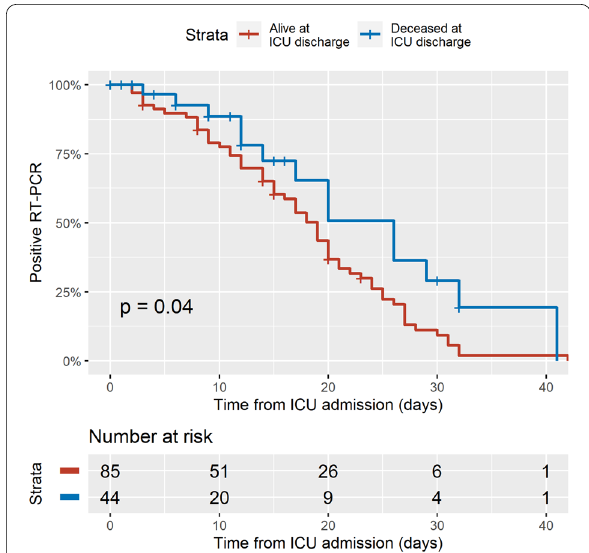
Fig. 2 Kaplan–Meier plot of the probability of remaining RT‑PCR positive for SARS‑CoV‑2. Blue line refers to patients deceased in ICU and red line to patients alive at ICU discharge. Right‑censoring was performed at the time of the last positive RT‑PCR in patients without